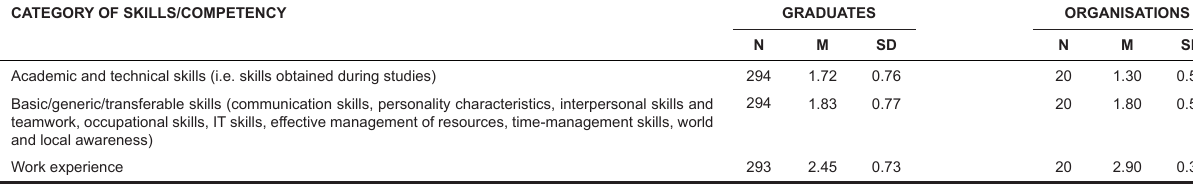
TABLE 4 Rating of categories of skills/competencies